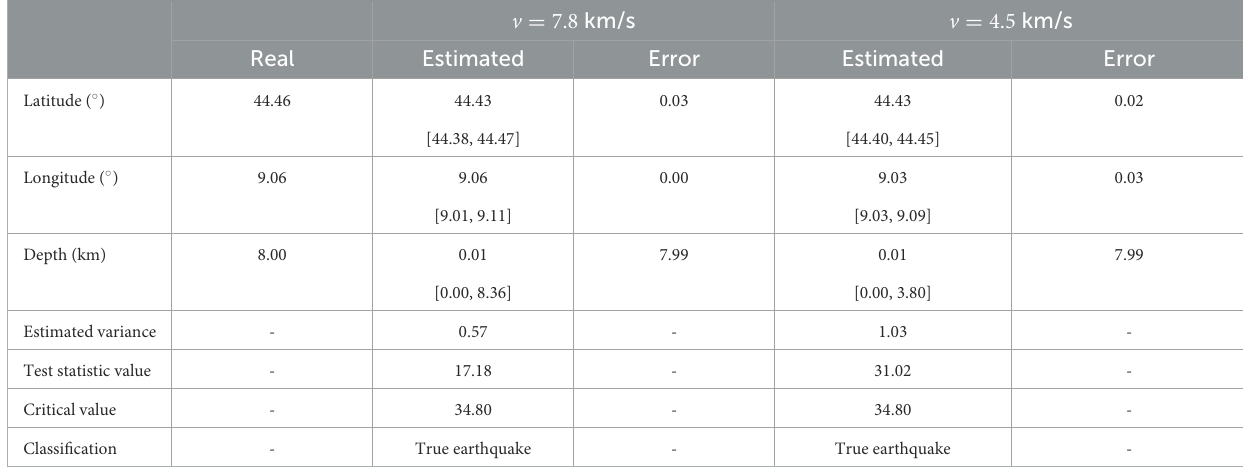
TABLE 1 Detection classification and earthquake parameters estimation for the EQN detection near Genova (Italy) assuming v equal to 7.8 and 4.5 km/s. v = 7.8 km/s v = 4.5